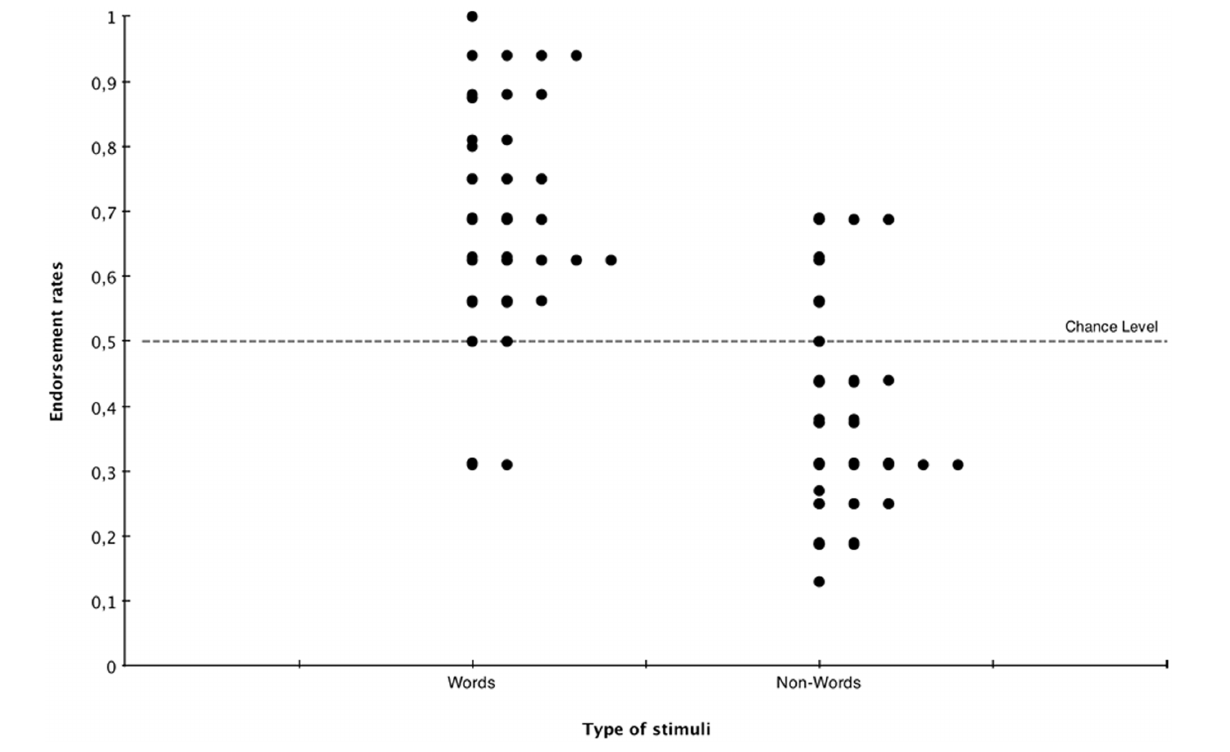
exclusion task, r = 0.460, p <